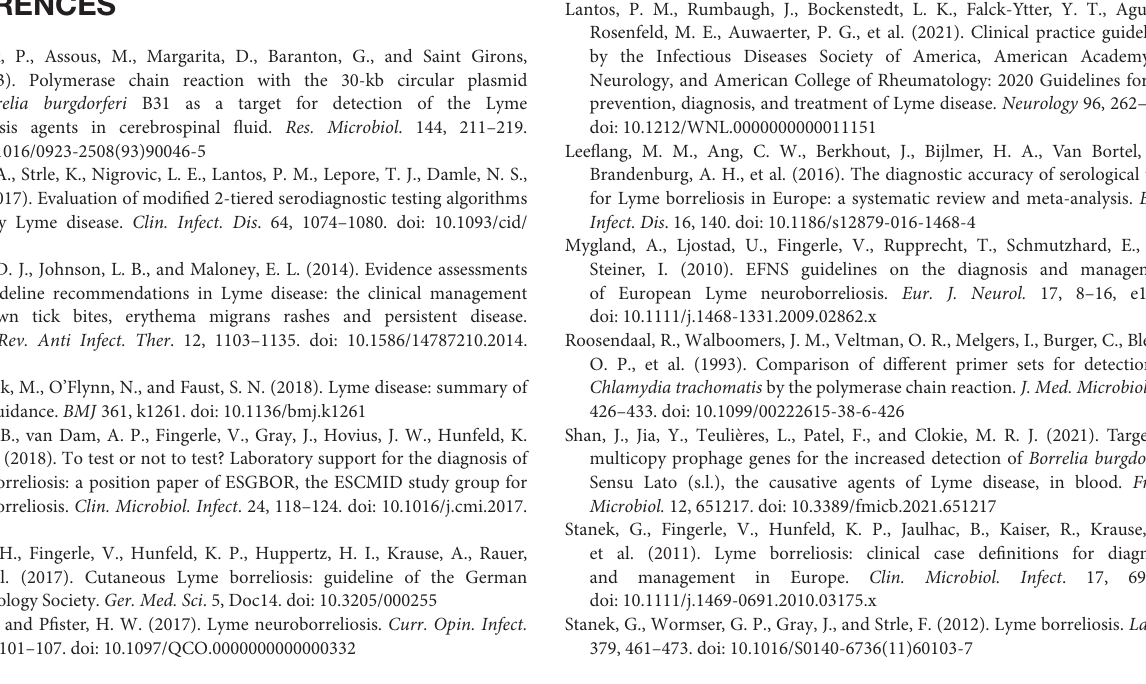
FIGURE 1 | in WB. (D,E) ROC curves of mean values WB and serum. (C) Comparison of healthy volunteers to early LD. Whole blood AUC = 0.697(95%CI 0.496–0.899). Serum AUC = 0.400 (95%CI 0.187–0.612). (D) Comparison of healthy volunteers and late LD. Whole blood AUC = 0.738 (95%CI 0.618–0.858). Serum AUC = 0.622 (95%CI 0.487–0.757). LB, Lyme borreliosis; WB, whole blood; ROC, receiver operating characteristic; AUC, area under the curve; CI, confidence interval; ns, non-significant; * p < 0.05, ** p < 0.01, calculated using independent-samples Mann-Whitney U-test for comparing participant